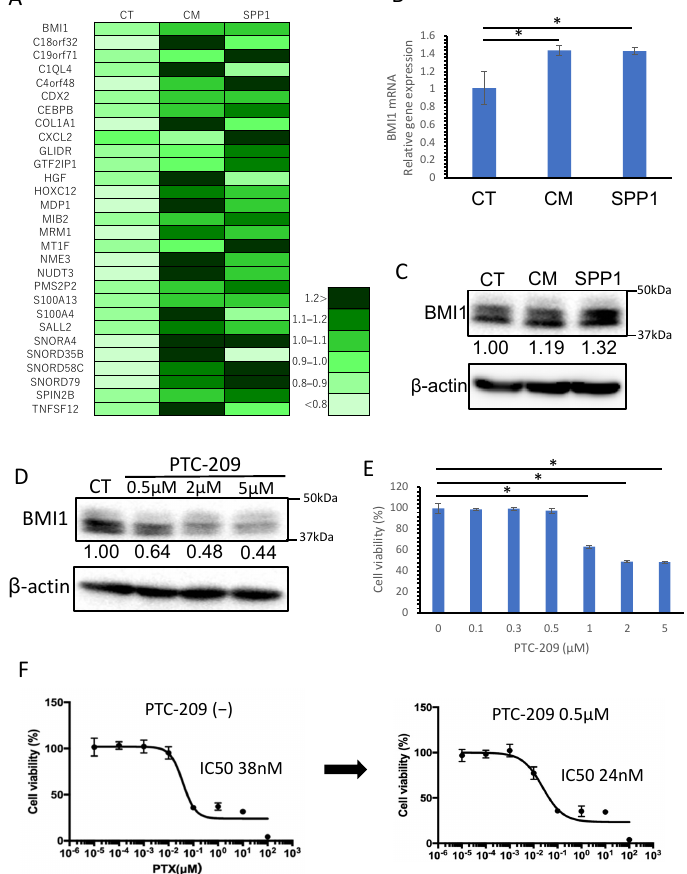
Figure 7. Gene expression analysis of cancer cells treated with the CM of macrophages or SPP1. ( A ) H23 cells were treated with the CM of macrophages and SPP1 for 24 h; then, the upregulated genes were detected by RNA-seq analysis (GEO: GSE212734). The upregulated genes in the cells treated with the CM of macrophages and SPP1. BMI1 expression was examined by qRT-PCR ( B ) and Western blot analysis ( C ). ( D ) H23 cells were treated with the indicated concentration of PTC-209 for 48 h, and the protein expression of BMI1 was determined by Western blot analysis. ( E ) H23 cells were treated with the indicated concentration of PTC-209 for 48 h, and cytotoxicity was examined by WST assay. ( F ) The standard curves were prepared by administering PTX to the H23 cells. The left side shows the standard curve without the administration of PTC-209, and the right side shows the standard curve under the administration of PTC-209 at a concentration of 0.5 µ M. CT refers to H23 cells without the CM of macrophages and SPP1 added. *: statistically significant, p value <